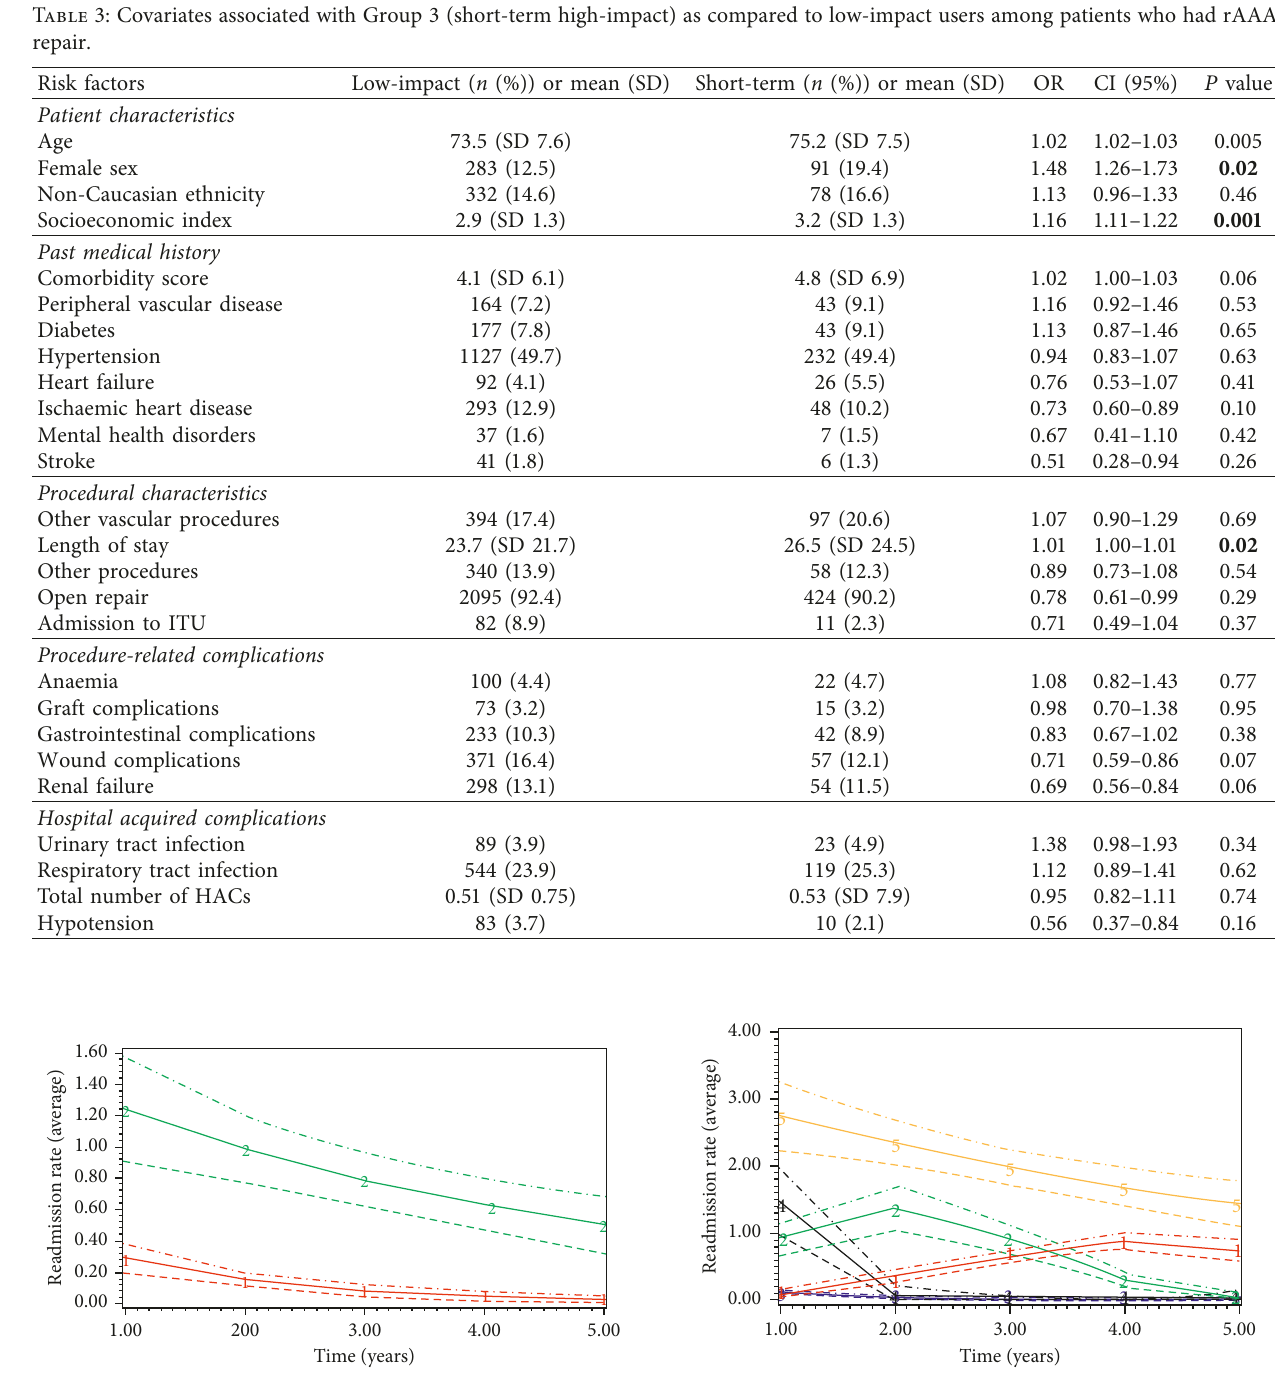
Figure 6: Subgroups among ruptured AAA patients with open repair and their trajectories of unplanned readmission rates (the horizontal axis starts with annual readmission rate at year one, and the dotted lines represent 95% confidence intervals for each